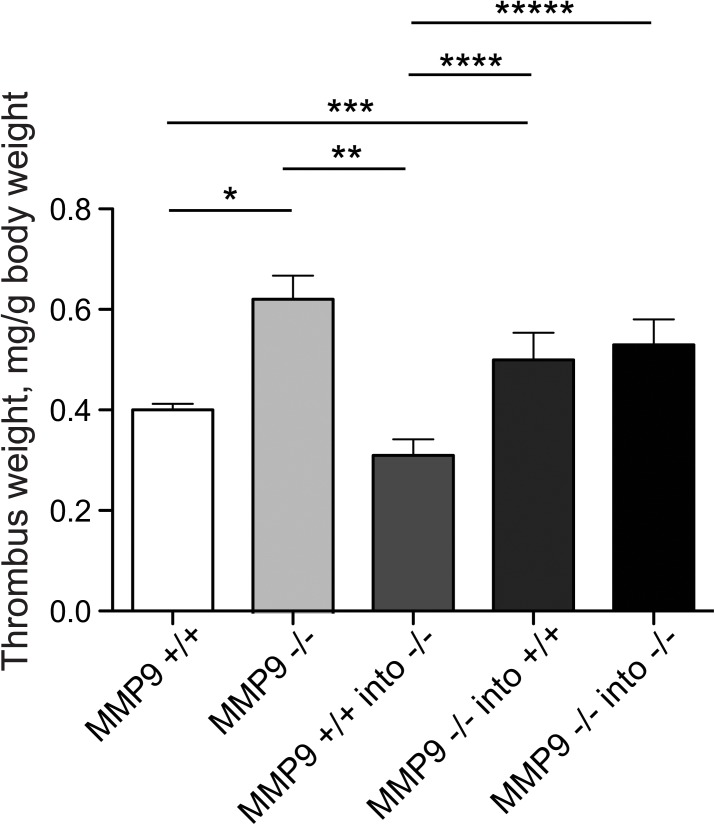
Role of bone marrow-derived MMP-9 in regulating thrombus resolution.Thrombus weights (g/kg) on day 12 after IVC ligation (DVT) are shown after bone marrow transplants between MMP-9+/+ and MMP-9-/- mice (N = 6–10; *p<0.05. N = 10 per group; **, ***p<0.05.).